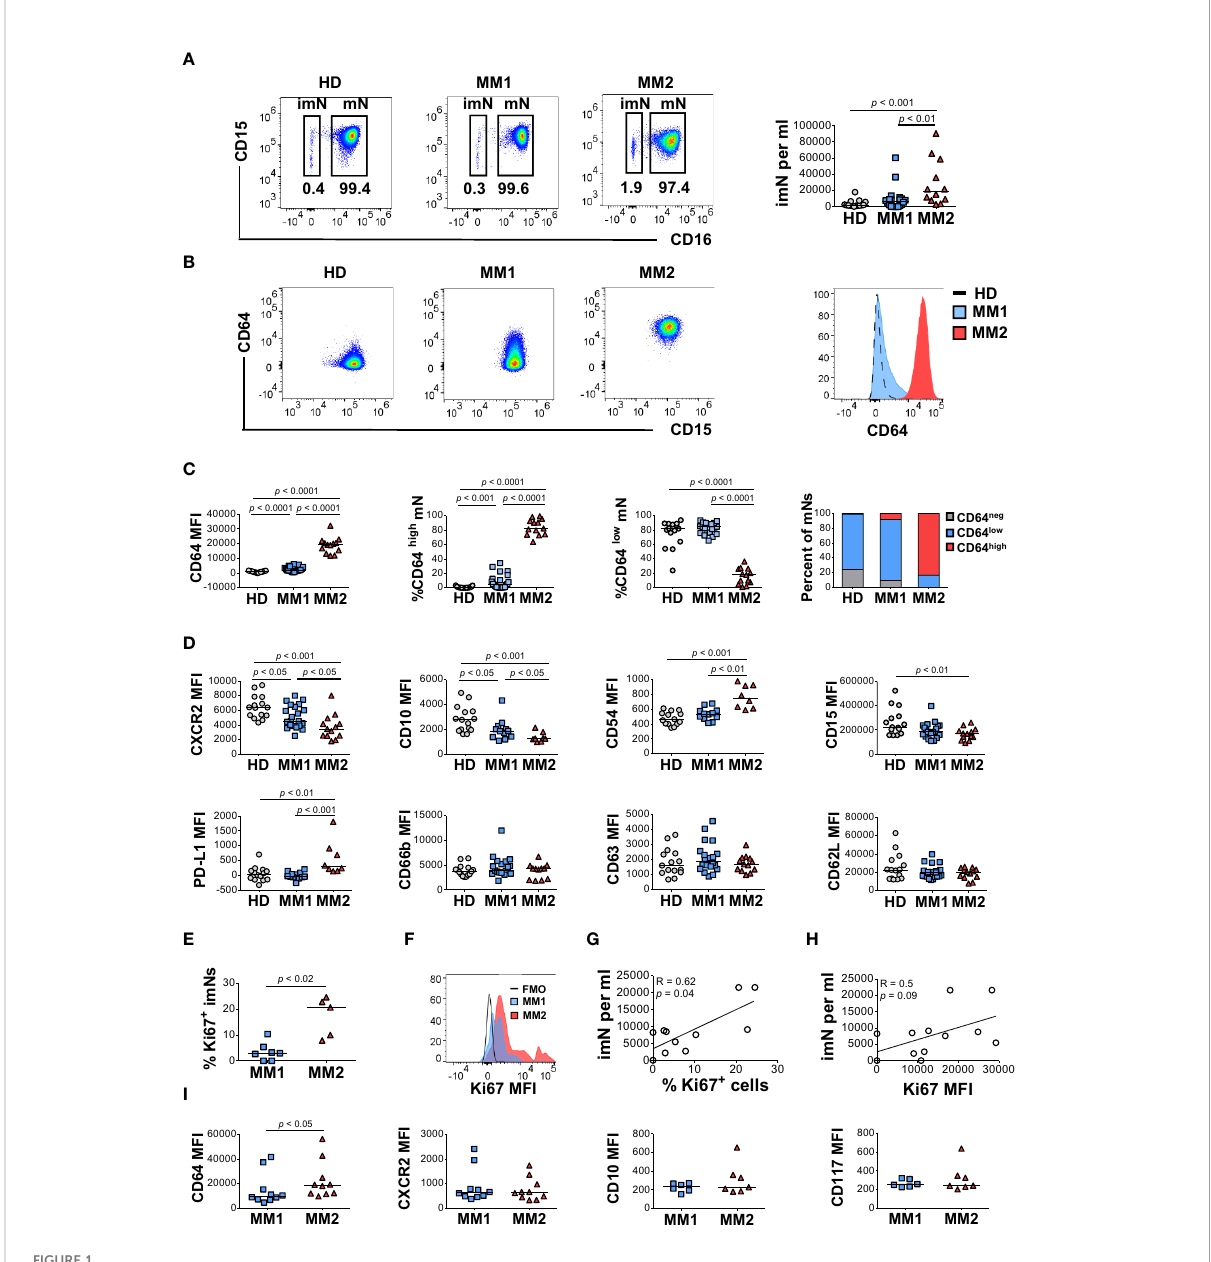
FIGURE 1 A subset of MM patients exhibits an altered neutrophil phenotype. (A) Left panel: representative cytograms of CD15 + CD16 + mature neutrophils (mNs) and CD15 + CD16 - immature neutrophils (imNs) in whole blood of a healthy donor (HD), MM1 patient, and MM2 patient. Right panel: frequency of imN per ml of blood of MM1 and MM2 patients and HD. (B) Representative cytograms of mNs of HD and MM1 and MM2 patients and a histogram overlay of CD64 expression. (C) Levels of expression of CD64 and percentages of CD64 high and CD64 low mNs in HD, MM1 and MM2 patients. (D) Levels of expression of maturation and activation markers on mNs of HD, MM1 and MM2 patients. (E) Percentage of Ki67 + imNs of total imNs. (F) Histogram overlay of Ki67 intracellular expression on imNs and (G) a correlation between imN frequency and the percentage of Ki67 + imNs, n=11. (H) Correlation between imN frequency and MFI of Ki67 + imNs, n=11. (I) Levels of expression of maturation and activation surface markers on imNs of MM1 and MM2 patients. MFI, median fl uorescent intensity. Statistical analyses were performed using the Mann-Whitney rank-sum test (A, C – E and I) or Spearman correlation (G, H) . Spearman correlation coef fi cients R and p values are indicated; bars and lines represent median values and simple linear regression analysis,